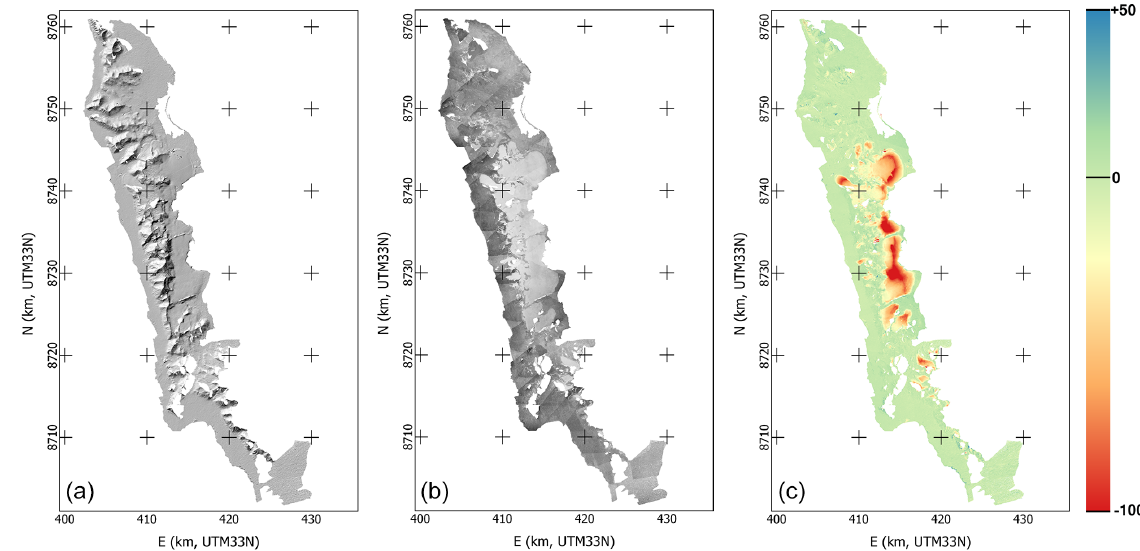
Figure 8. Overview of the data resulting from the processing of the 1936 images over Prins Karls Forland. From left to right: Hillshade, orthoimage, DEM difference with the NPI 2008